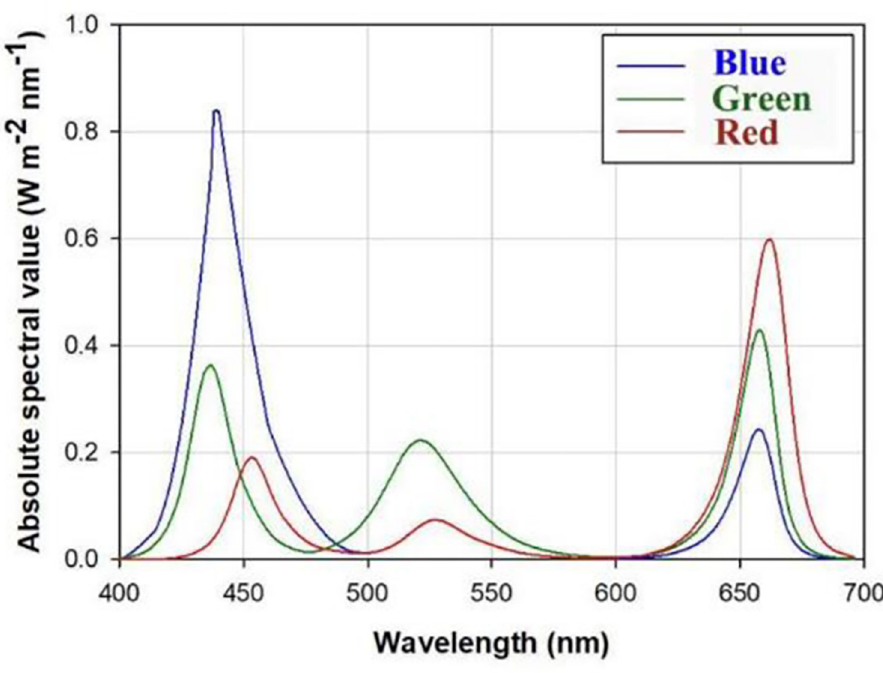
Fig 1. Absolute spectral values in accordance with wavelengths between 400nm and 700nm for three types of light-emitting diode (LED) lighting spectra from red-, green-, and blue-lights.